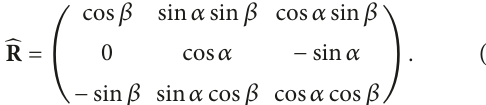
system 𝑜𝑥𝑦𝑧 . Moreover, a rectangular coordinate system 𝑂𝑆𝐻 is attached to the plane 𝑂𝑜𝑜 󸀠 . The 𝑆 -axis is along the 󳨀󳨀→ 𝑂𝑜 󸀠 . The 𝐻 -axis is along the 𝑍 -axis. We denote the vector angle between the 𝑋 -axis and the 𝑆 -axis as 𝜃 𝑠 . We denote the three-dimensional coordinates of the point 𝑜 in the global- coordinate system 𝑂𝑋𝑌𝑍 as 𝑥, 𝑦, 𝑧 , the moving platform’s rotation with respect to the 𝑋 -axis as 𝛼 , and the moving platform’s rotation with respect to the 𝑌 -axis as 𝛽 . The orientation matrix of the local-coordinate system 𝑜𝑥𝑦𝑧 with respect to the global-coordinate system 𝑂𝑋𝑌𝑍 is described